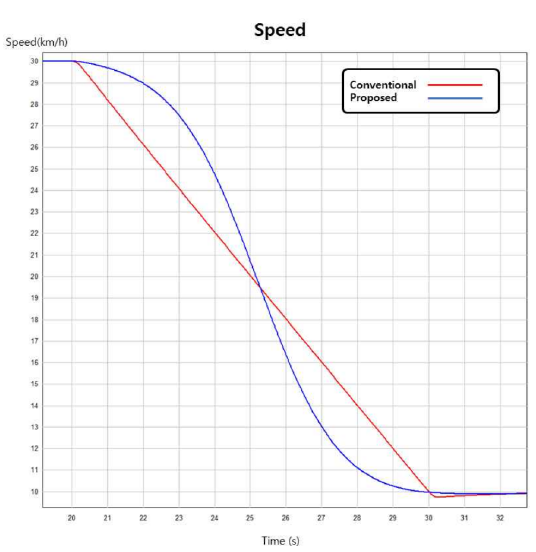
Figure 22. Speed comparison of conventional braking and proposed method when changing speed from 30 to 10 km/h. Both control methods reached 10 km/h within 10